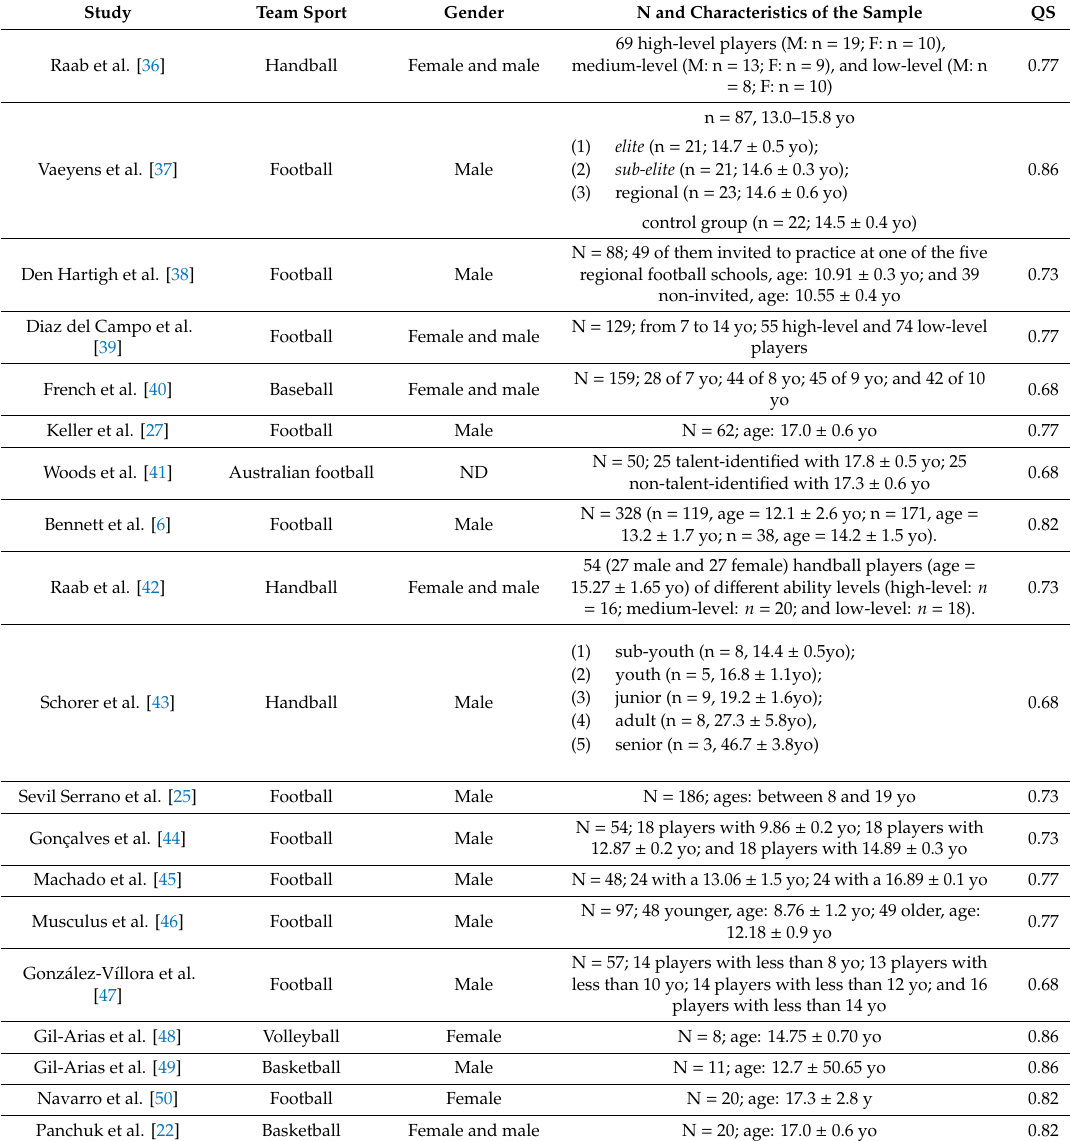
Table 1. Summary of the studies included in the systematic